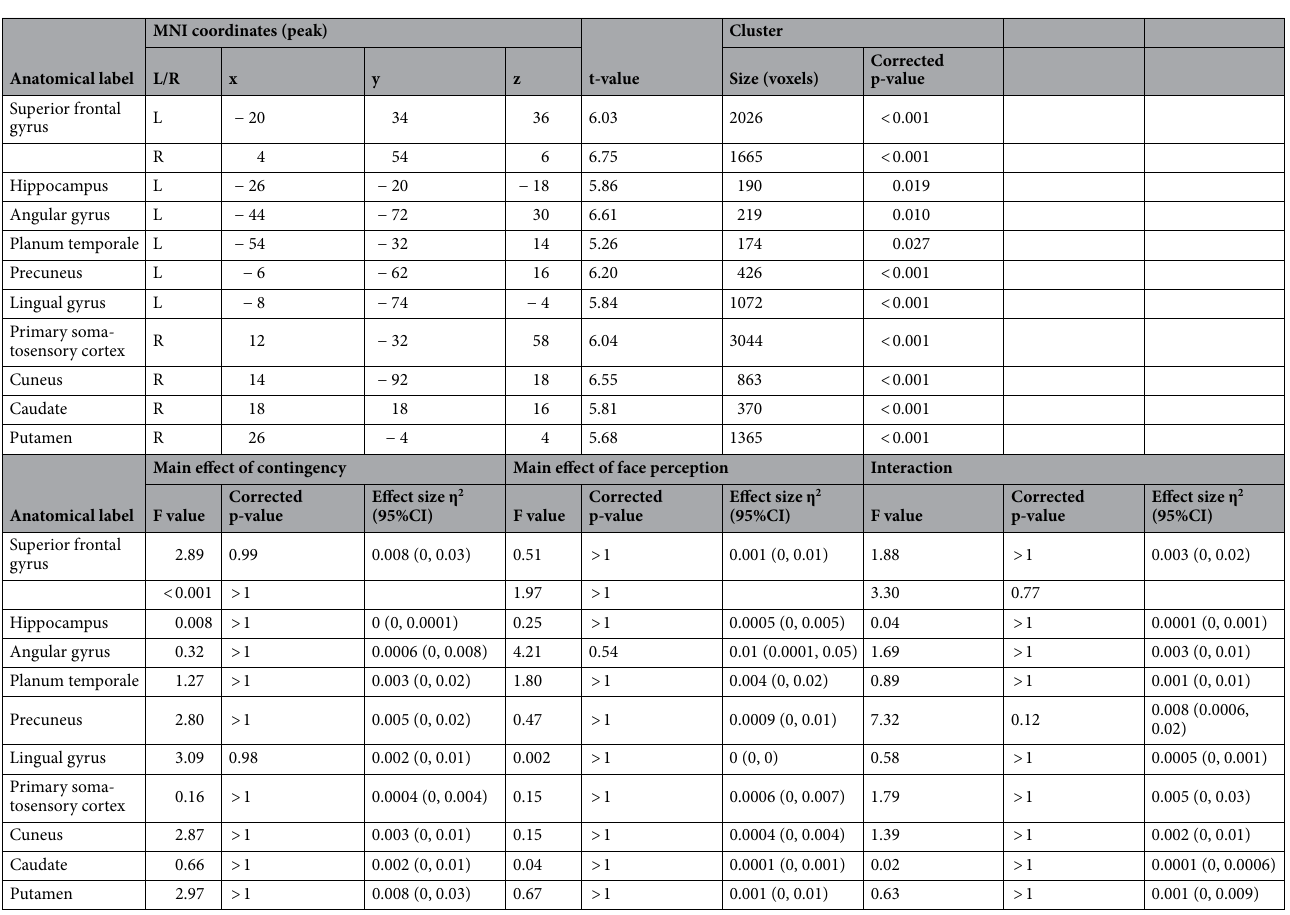
Table 3. Brain regions representing a significant positive contingency effect and region of interest (ROI) analysis results. Peaks were obtained from the positive contingency effect contrast (i.e., [FC + OC] > [FN + ON]). Other details are similar to those presented in Table